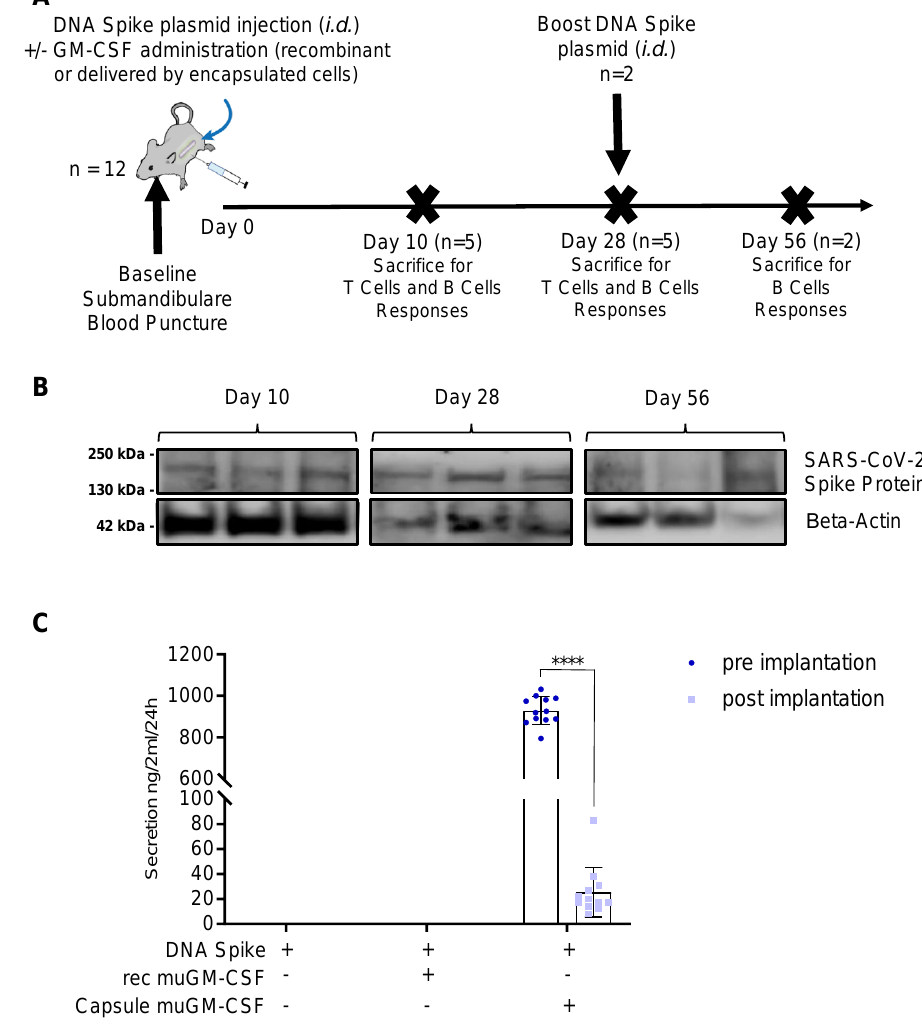
Figure 1. Vaccination Strategy. ( A ). Vaccination scheme. Three groups of 12 mice were immunized at Day 0 by an intradermal injection of DNA plasmid coding for SARS-CoV-2 spike protein. For two groups, the immunization was adjuvanted either with recombinant muGM-CSF or with muGM-CSF secreted by encapsulated cells. On the day of immunization, a submandibular blood puncture was performed for baseline serum isolation. On Days 10 and 28, 5 mice per group were sacrificed to assess T Cell and B Cell responses. At Day 28, the 2 remaining mice per group received a boost DNA spike plasmid injection and were kept until Day 56 for B Cell responses assessment. ( B ). Dermal SARS-CoV-2 Spike protein expression by western blot analysis. Skin punch biopsies were taken at the site of intradermal injection from all animals, digested, and analyzed by western blot for the presence of the SARS-CoV-2 spike protein. Three randomly selected mice per time points are represented. ( C ). muGM-CSF Adjuvant quantification by ELISA. The muGM-CSF secreted by encapsulated cells was quantified by ELISA before and after implantation in mice. **** p <